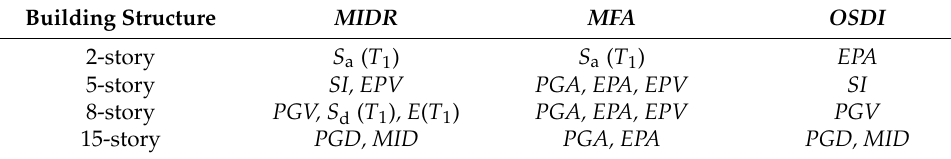
Table 8. The most efficient and sufficient IMs for different